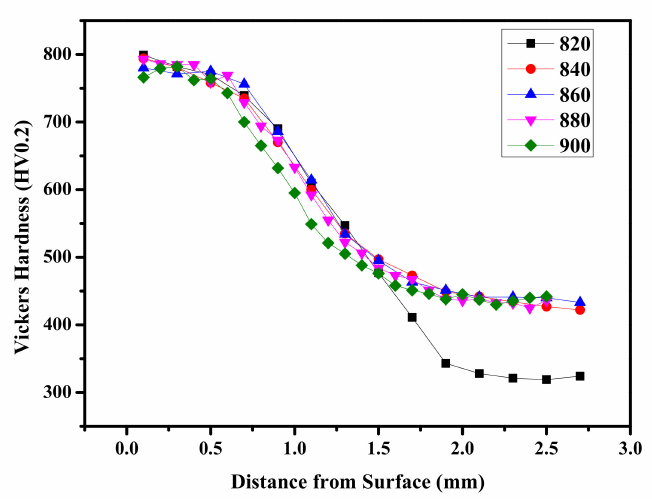
Figure 4. The in-depth hardness distribution of the specimens austenitized at different temperatures, as indicated by the serial